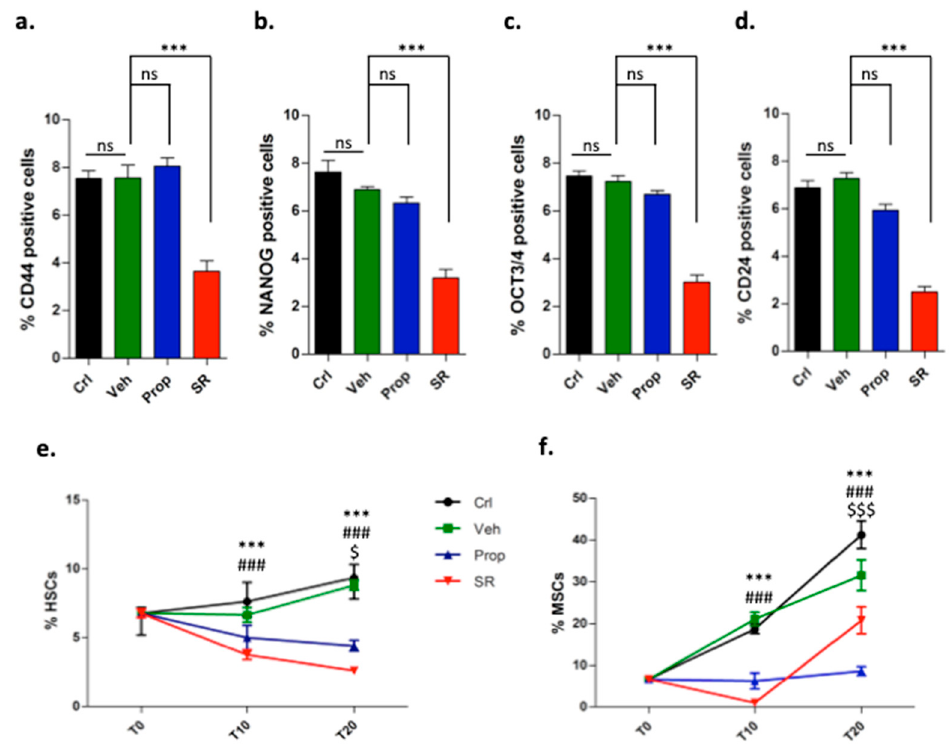
Figure 2. FACS analysis and relative quantification of: ( a – d ) CD44 + , NANOG + , OCT3 / 4 + , and CD24 + cells gated on CD45 − tumor cells at T20. ( e ) Hematopoietic stem cells (HSCs) (% of CD117 + , Sca1 + gated on Lin − ) at the baseline (T0), T10, T20. ( f ) Mesenchymal stem cells (MSCs) (% of CD29 + , CD44 + gated on CD106 + , Sca1 + , CD73 + , CD45 − , CD11b − ) at T0, T10, T20.